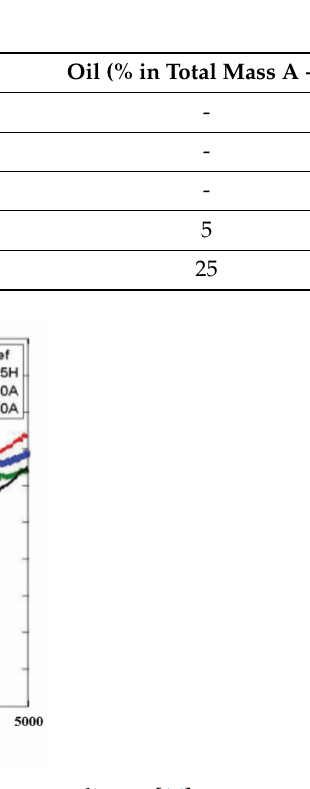
Figure 2. Sound absorption coefficient of the different samples according to